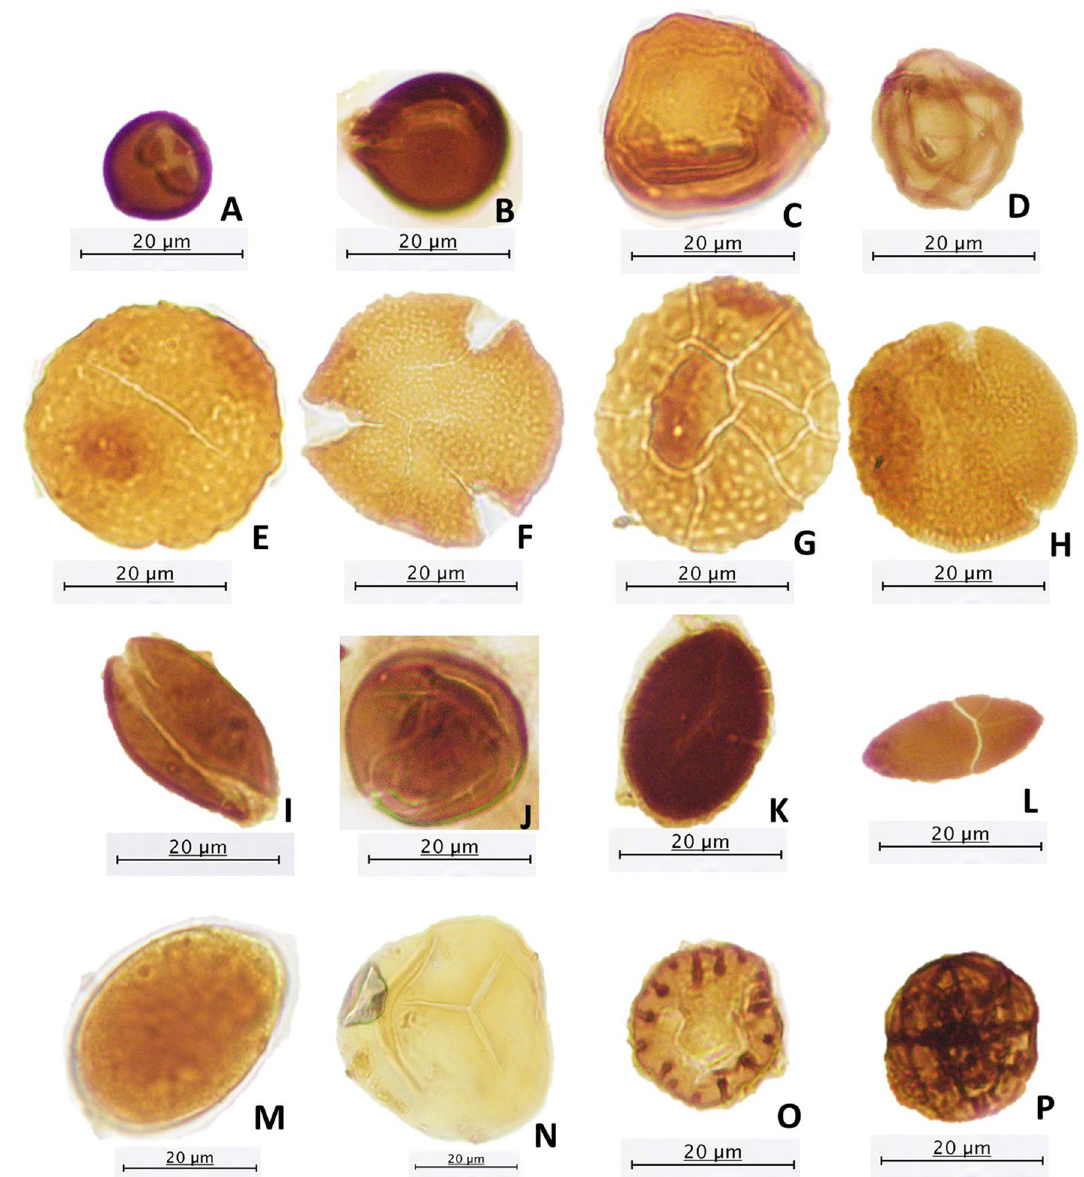
Figure 4. Some of the pollen and spores recovered from the Mukah coal samples being studied. ( A , B , D , I – M , O , P ) Fungus, ( C ) Casuarina type, ( E ) Chepalomappa , ( F ) Brownlowia type, ( G ) ? Chepalomappa type, ( H ) Blumeodendron , ( N ) Acrostichum aureum